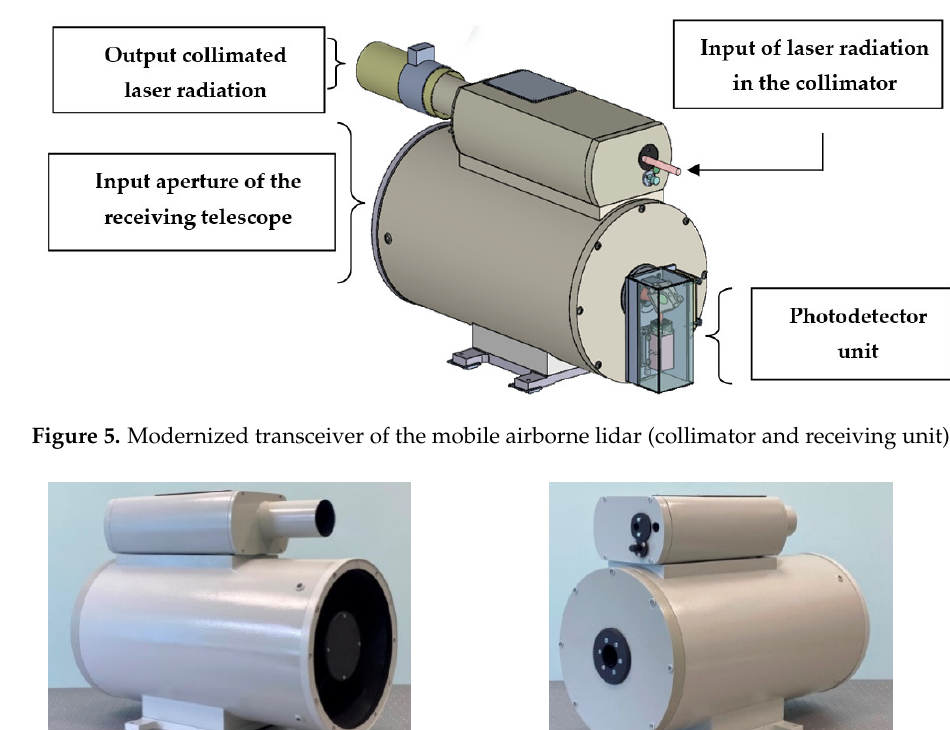
Table 1. Main parameters of the modernized airborne lidar.